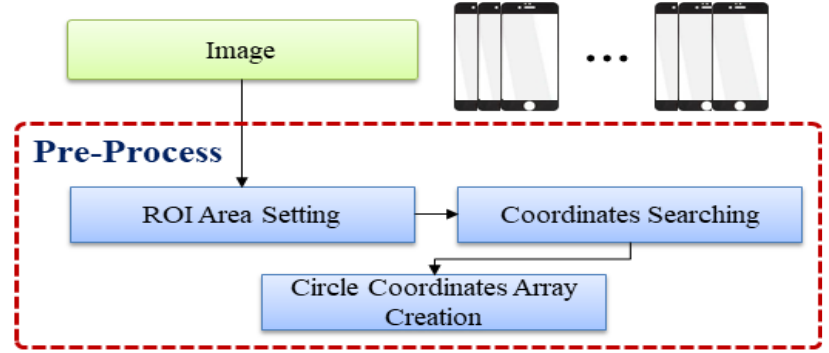
Figure 7. Preprocessing. Figure 7.